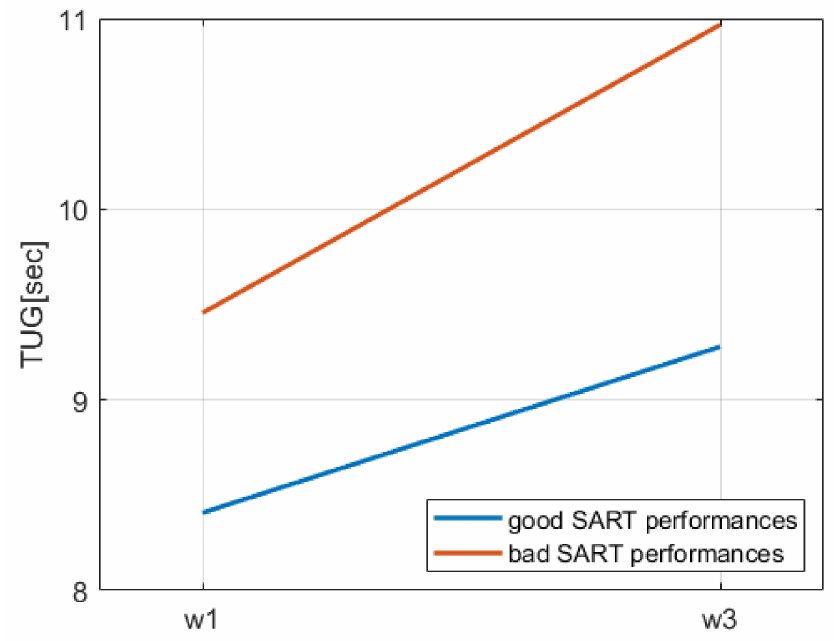
Figure 3. TUG at wave 1 and wave 3 for participants who only had good performances in SART at wave 1 and those who had at least 1 bad